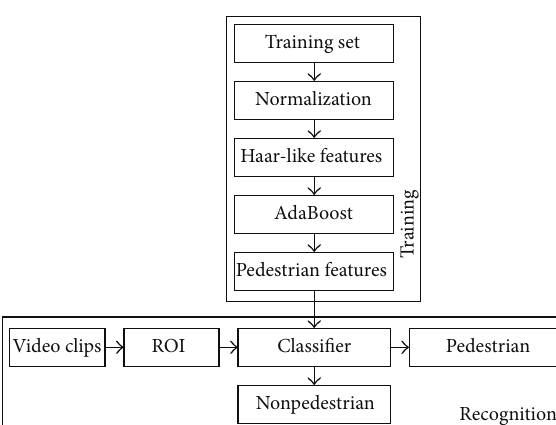
Figure 3: Flowchart of Haar-like based pedestrian detection.